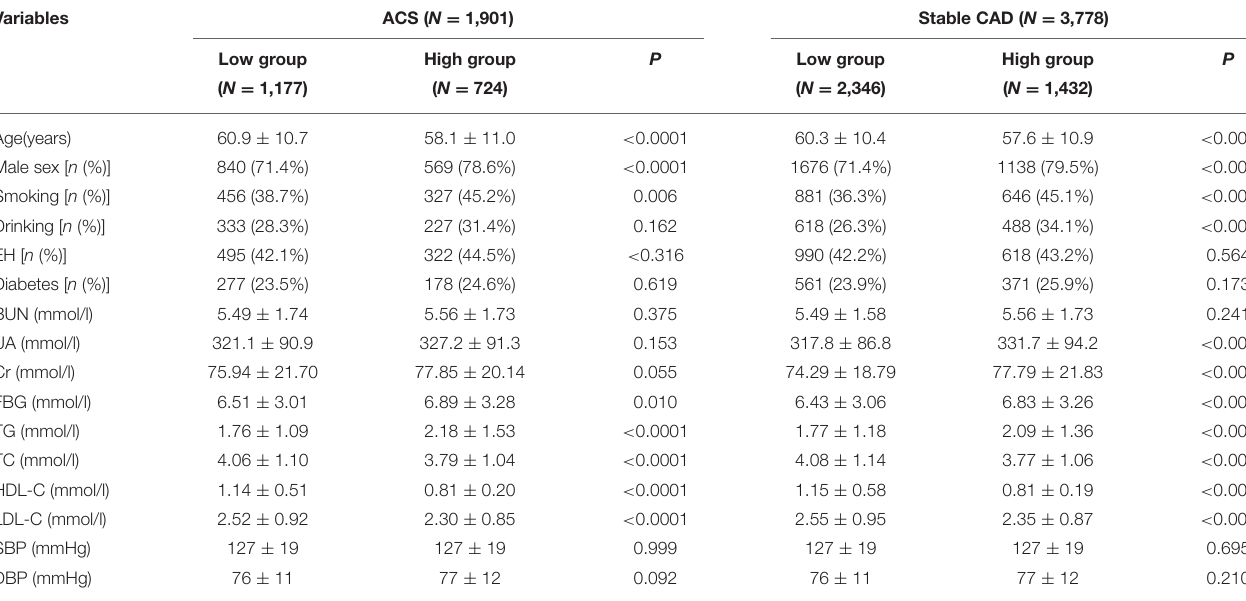
TABLE 1 | Clinical and laboratory